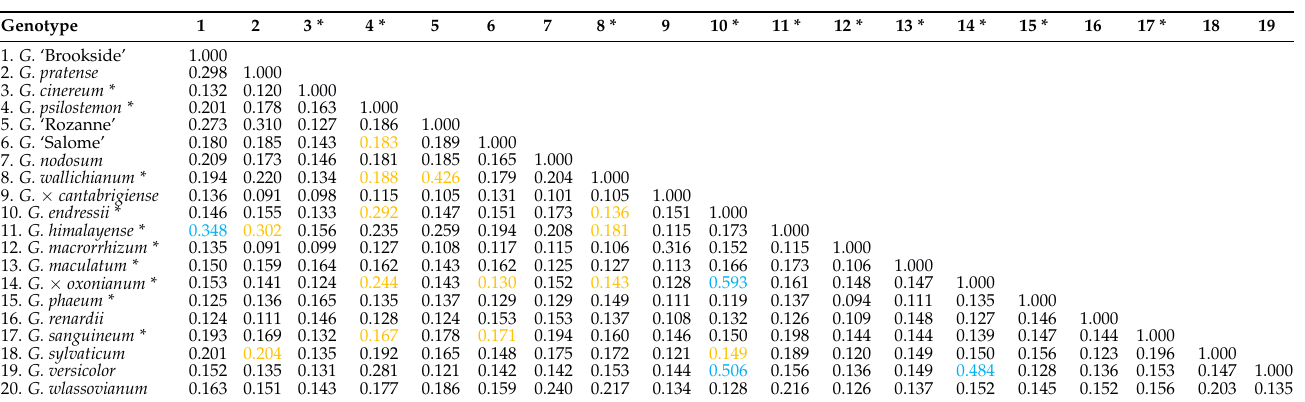
Table 3. Calculation of the pairwise genetic proximity measures (Jaccard similarity coefficients) of some different Geranium species and cultivars used in obtained cross combinations. When more than one species was available, a mean value was used and designated by *. The numbers depicted in orange are intergroup cross combinations; numbers in blue are intragroup